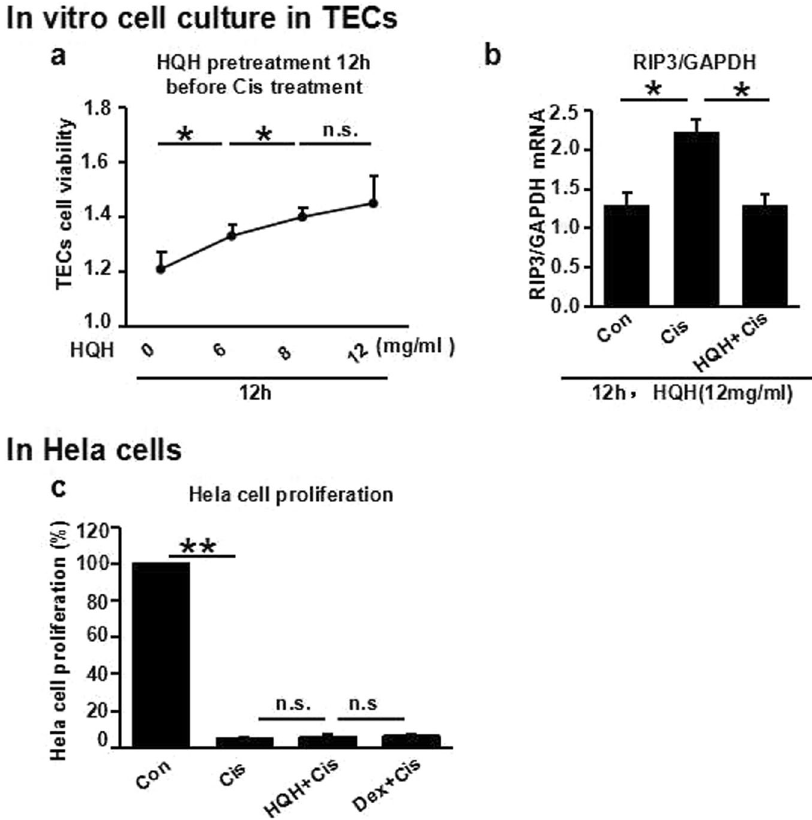
Figure 5. HQH reduced the damage of renal tubular epithelial cells induced by cisplatin, but did not affect the antitumor activity of cisplatin in Hela cells. ( a ) CCK 8 experiment in renal proximal tubules after HQH (0/6/12/18 mg/ml) pretreatment 12 h before cisplatin (75 μ M) treatment 12 h ( * P < 0.05, n = 5/group). ( b ) RIP3 expression are decreased in renal proximal tubules after HQH (12 mg/ml) pretreatment 12 h before cisplatin (75 μ M) treatment 12 h ( * P < 0.05, n = 5/group). ( c ) CCK8 cell proliferation assay for Hela cell. Con: Without stimulus; Cis: 30 mM; HQH: 10 mg/ml; Dex: 50 μ M; ( ** P < 0.01, n =